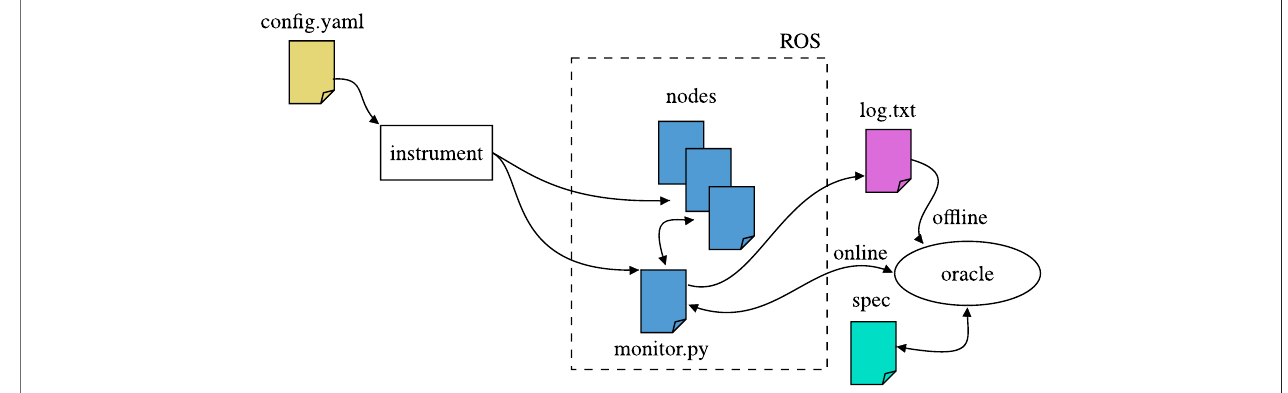
FIGURE 10 | High-level overview of ROSMonitoring (Ferrando et al., 2020). Everything starts with a con fi guration fi le that guides the instrumentation process, in which the ROS nodes are modi fi ed (if necessary) and the monitor code is synthesised. Then, depending on the user ’ s choice, RV is carried out of fl ine, where a log fi le is generated for future analysis, or online, where the intercepted ROS messages are propagated to an oracle component for incremental analysis.